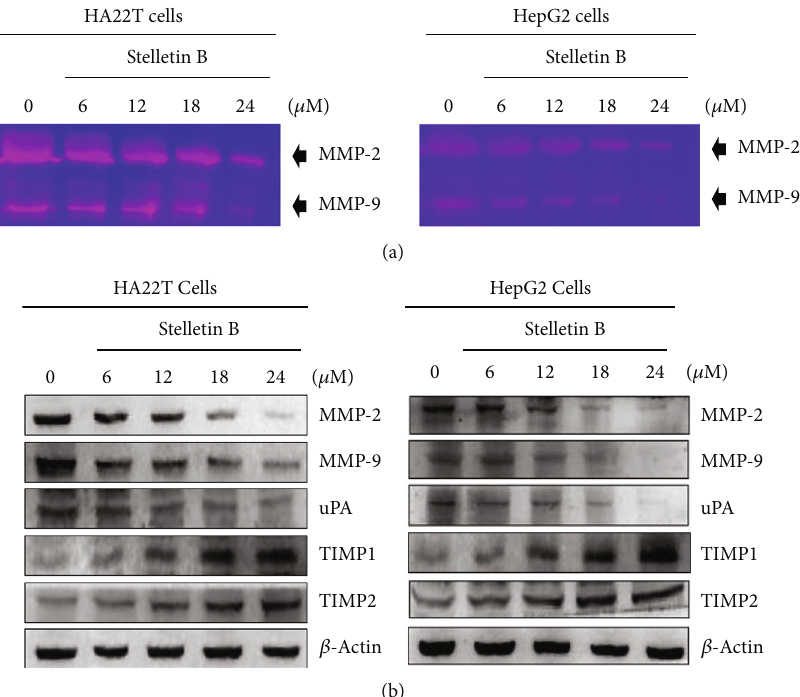
Figure 4: Stellettin B reduced the expressions of MMP-2, MMP-9, and uPA, and increased the expressions of TIMP-1 and TIMP-2. HA22T and HepG2 cells were treated with di ff erent concentrations of Stellettin B (0, 6, 12,18, 24 μ M) for 24h, and conditioned media and cell lysates were collected for analysis. (a) Examination of MMP-2/-9 activities by gelatin zymography. (b) The expression levels of MMP-2/-9, uPA, and TIMP-1/-2 were analyzed by western blotting of total cell lysates of HA22T and HepG2 cells treated with Stellettin B. Zero refers to cells treated with DMSO vehicle as a control. β -Actin was used as the internal control.